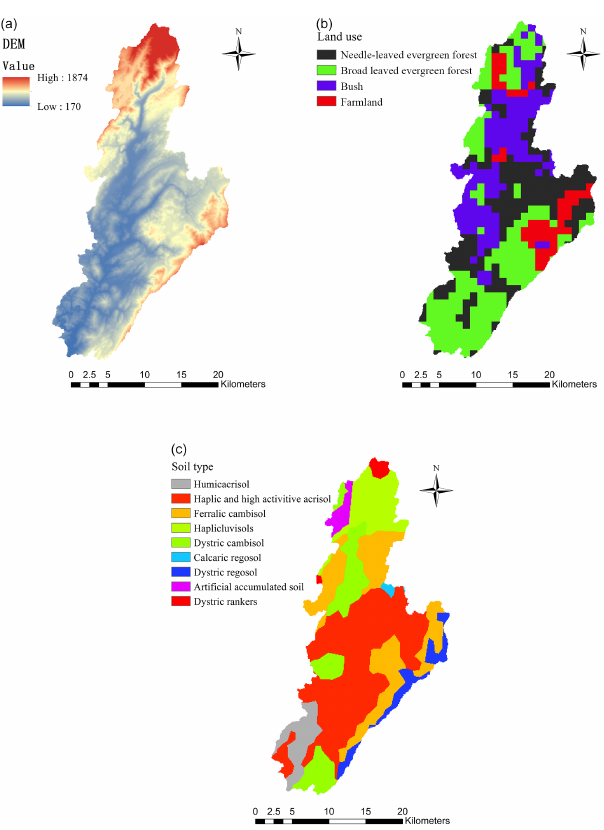
Figure 2. Terrain properties of Tiantoushui catchment: (a) DEM, (b) land use type and (c) soil type.